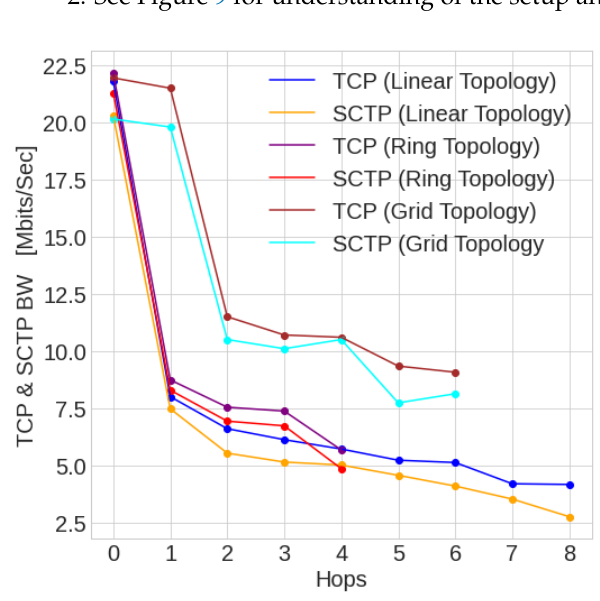
Figure 22. W-iLab1.t TCP and SCTP bandwidth. 5. TCP and UDP Latency: UDP latency is increased in linear topology because of the distance from node 0 to node 9, i.e., from 575 µ s to 1 s, in order to cover more hops, while TCP latency is minimal, i.e., between 500 µ s and 24 ms. For other topologies, i.e., ring and grid, UDP latency is minimal (Figure